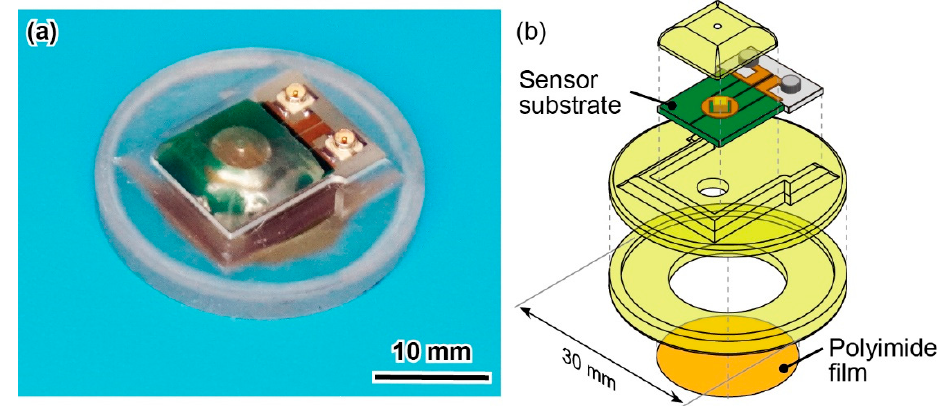
Figure 8. ( a ) Photograph and ( b ) schematic illustration of developed pulse wave